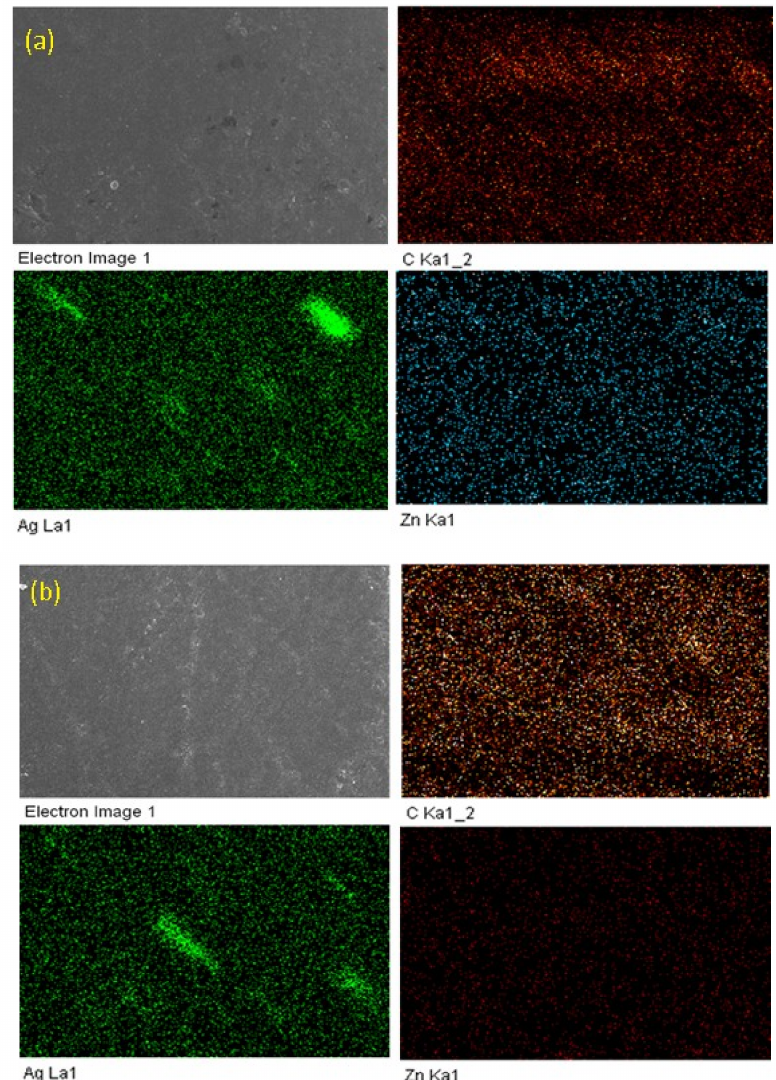
Figure 2. ( a , b ) EDX mapping for F1 and F2